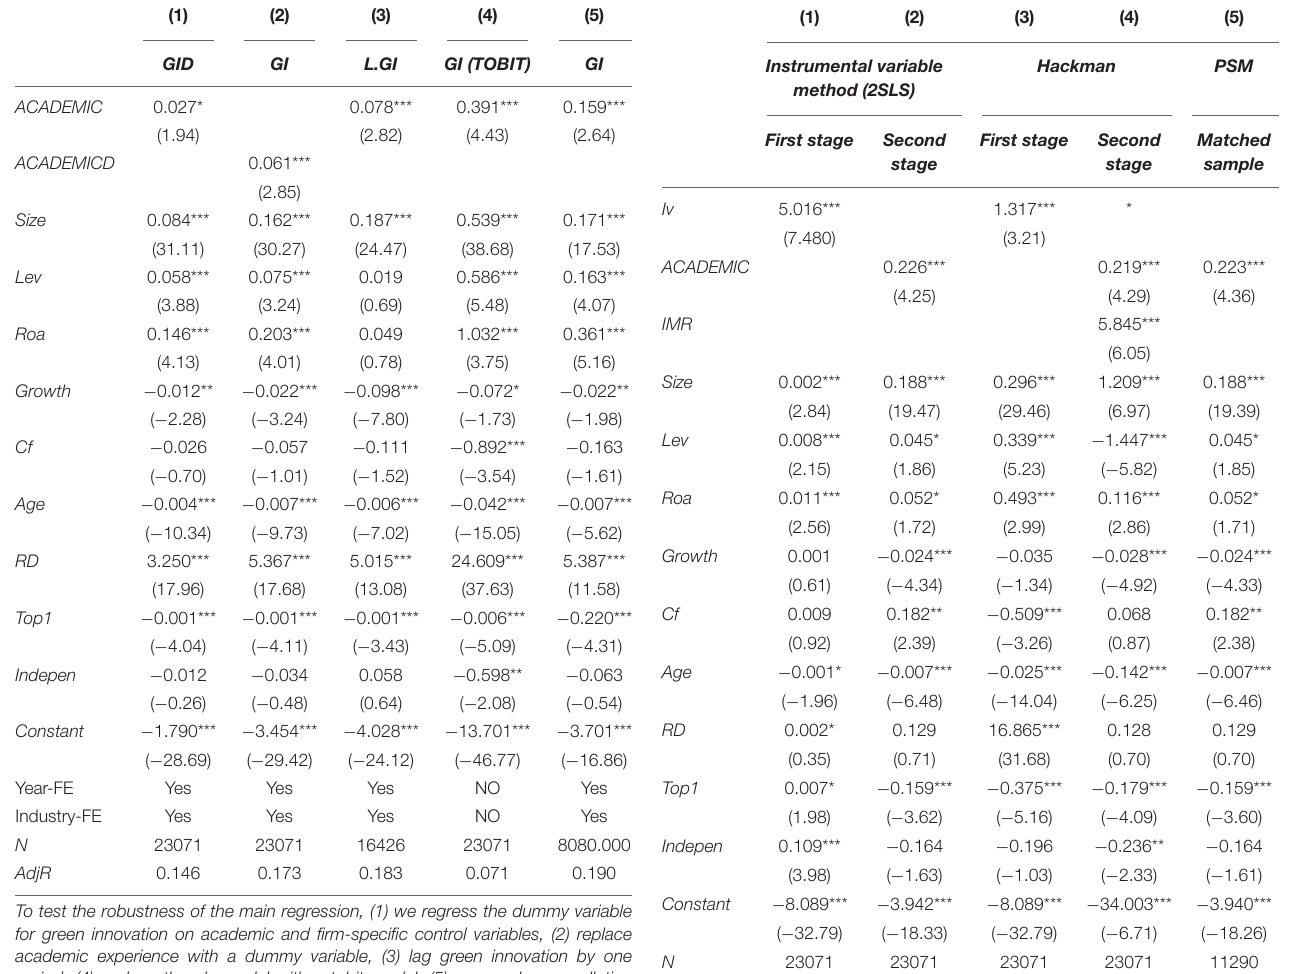
TABLE 6 | Robustness test results. TABLE 7 | Endogeneity